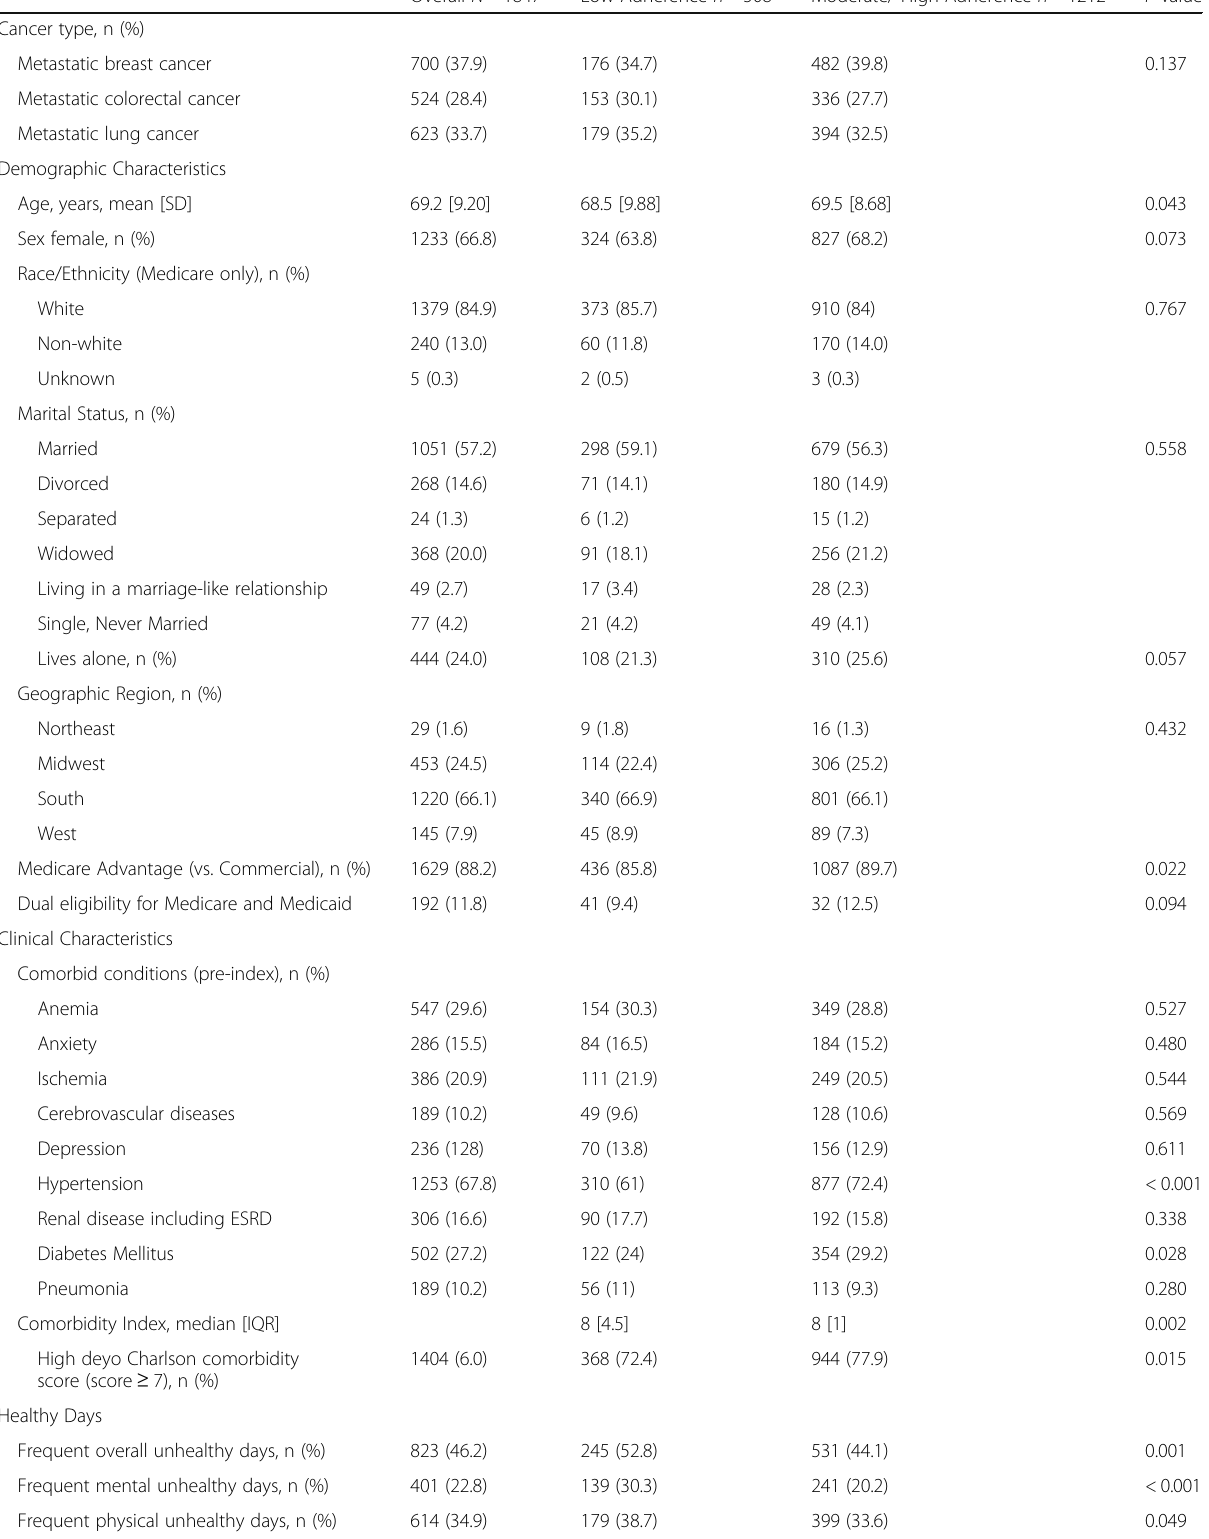
Table 1 Demographics of survey respondents by level of comorbidity medication